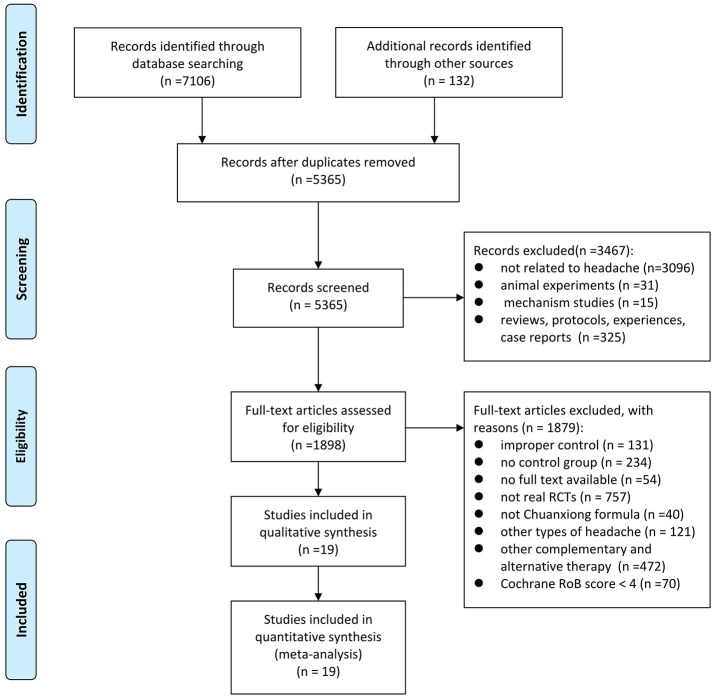
Flow diagram of the search process.